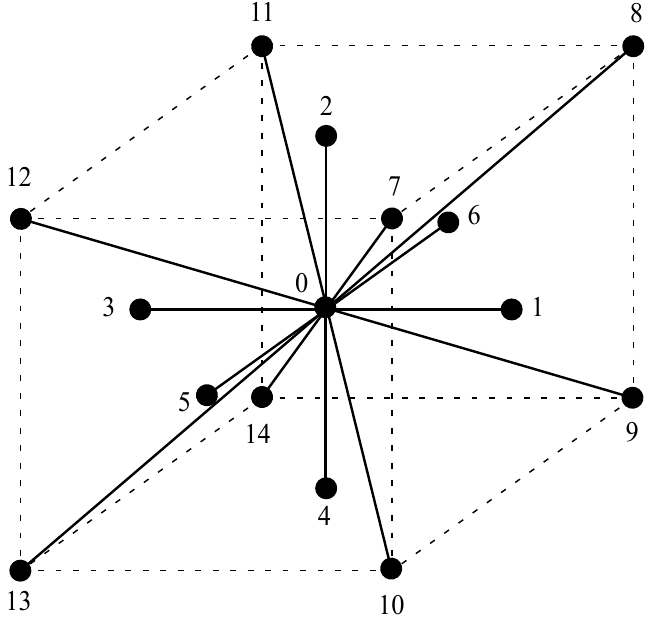
Figure 1. Discrete velocity set of the D3Q15